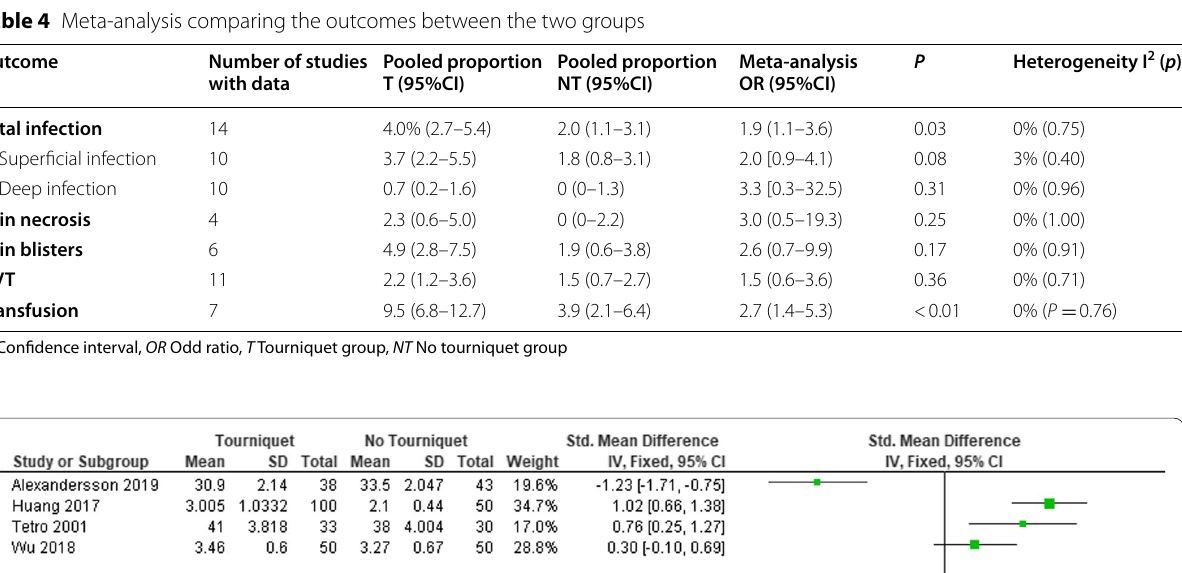
Pooled proportion Pooled proportion Meta-analysis with data T (95%CI) NT (95%CI) OR (95%CI)